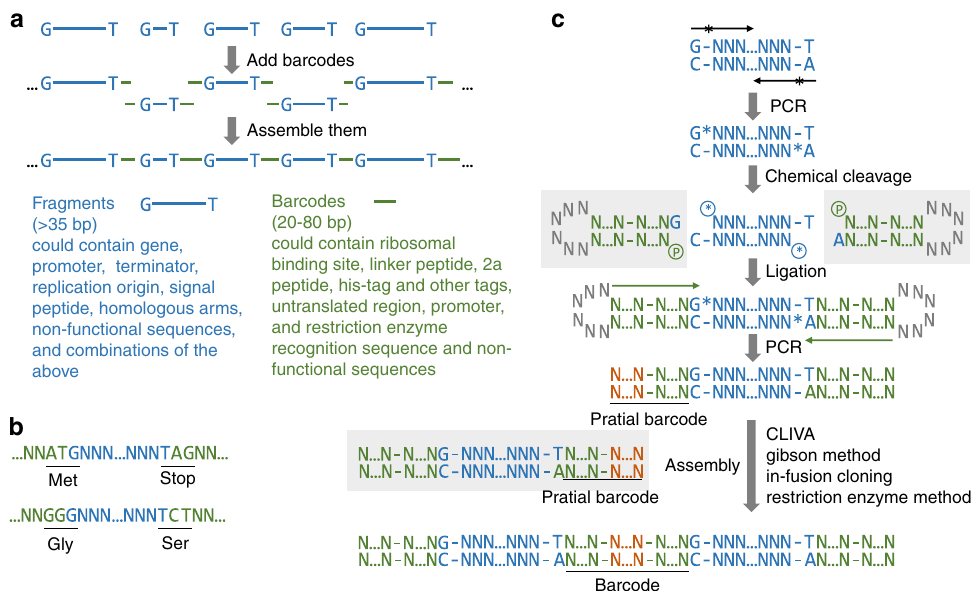
Fig. 1 GT assembly standard (GTS) for constructing plasmid from standard parts (fragments and barcodes). a The plasmid construction work fl ow and examples of fragments and barcodes; b Using minimal conserved sequence (one nt long, G and T) in fragment eliminated scar in most DNA assembly practices. Two scarless connections are shown here. c Mechanism of adding two partial barcodes to one fragment, and mechanism of using two partial barcodes containing long overlapping sequence or restriction enzyme cutting sites (highlighted in orange N … N) to assemble two fragments by using various DNA assembly methods. * Indicates phosphorothioate (PS) bond; * in a circle indicates PS group; − indicates phosphodiester bond; P in a circle: phosphate group; ... indicates omitted, unspeci fi ed nucleotides. Items in gray shade are new items introduced in the step. Long black arrows are the oligos (termed as Fragment oligos [Foligos]) used to amplify fragment, and long green arrows are the oligos (termed as Assembling oligos [Aoligos]) used to amplify barcoded fragment. The oligos used to prepare barcode halve with stem-loop structure are termed as Barcoding oligos